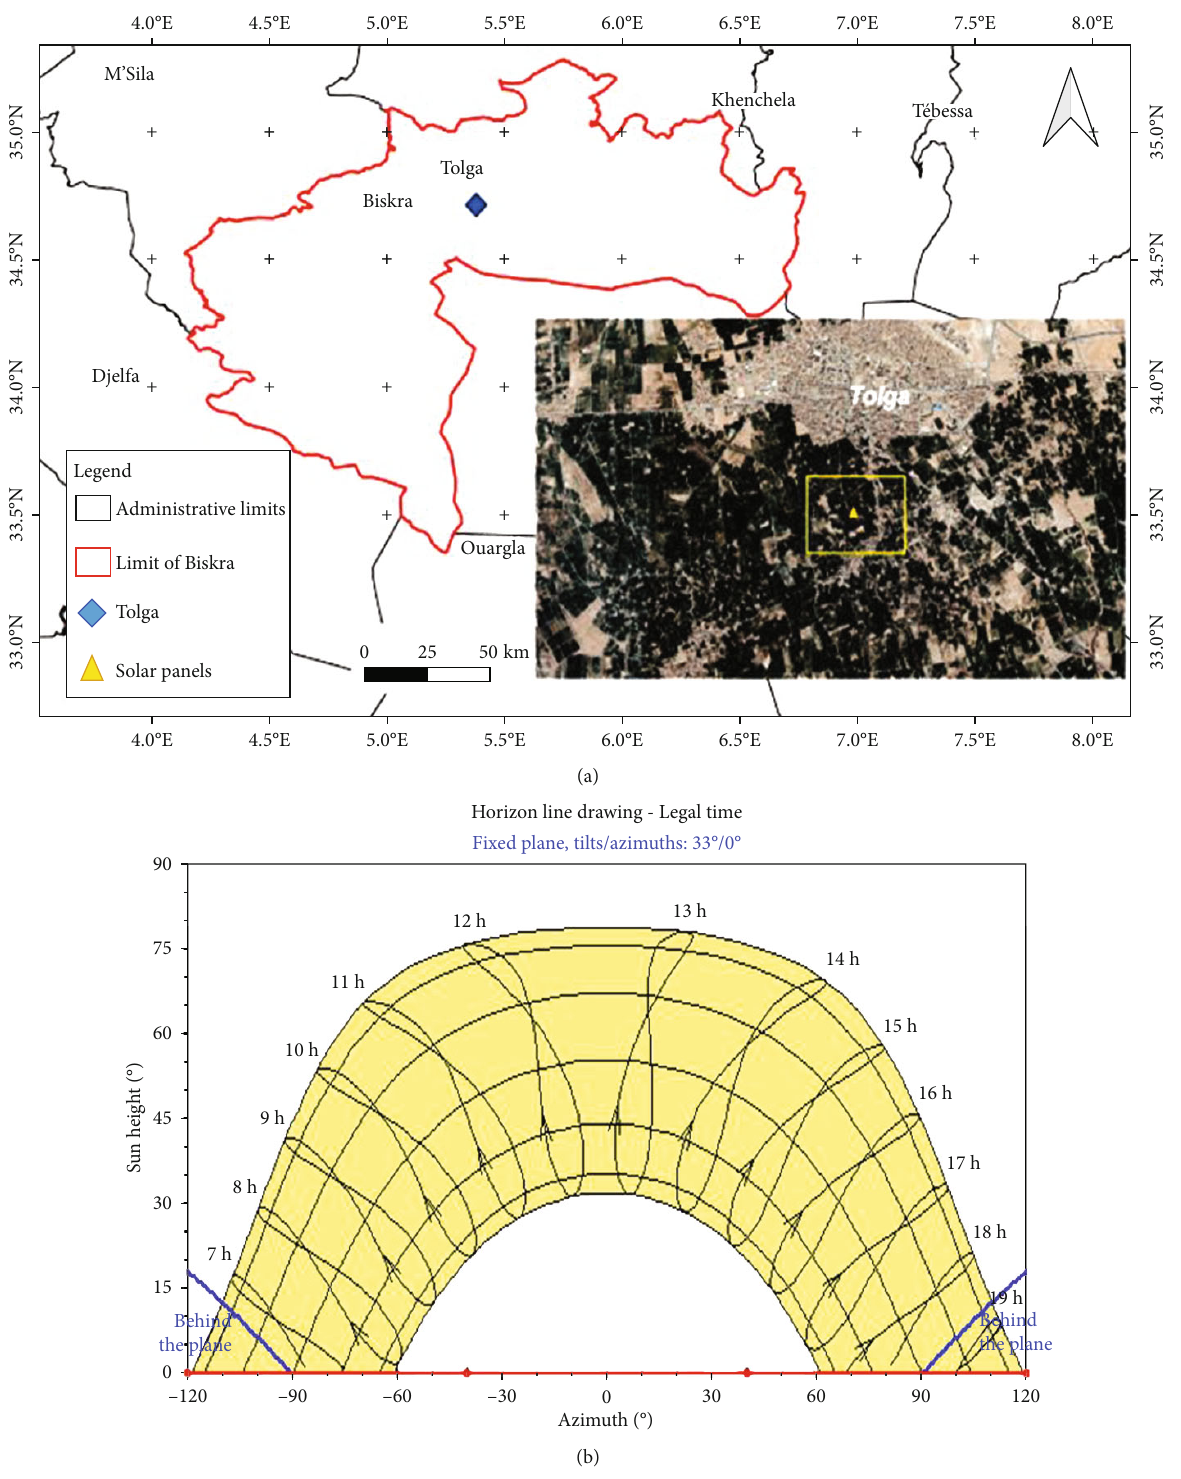
Figure 1: (a) Site location of latitude: 34 ° 42 ′ 59 ″ , longitude: 5 ° 22 ′ 33 ″ , and altitude: 151m above sea level. (b) Solar horizon line according to inclination angles of panels of the studied PV injected-into-grid system ( fi xed tilted plane, plane tilt/azimuth and full system orientation: 33 °